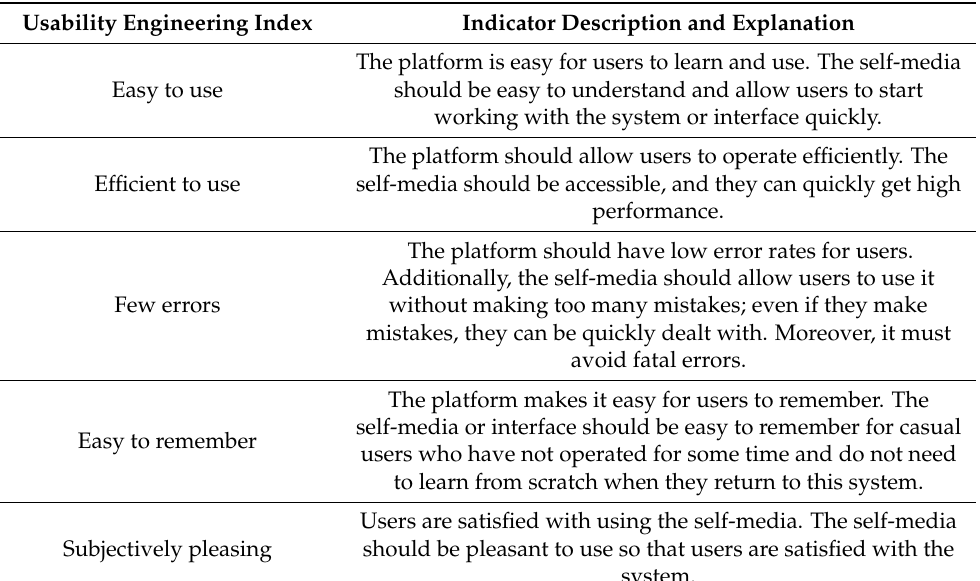
Table 2. Usability engineering index and